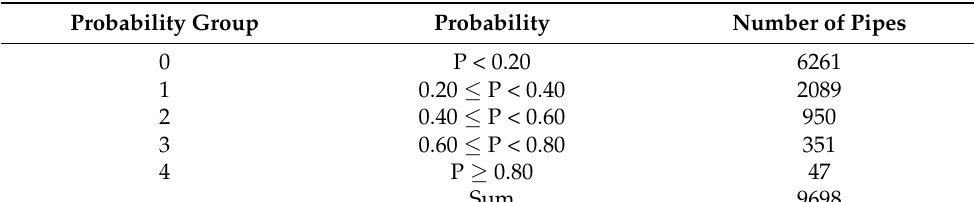
Table 6. Groups of pipes based on p values from RF-BA analysis.